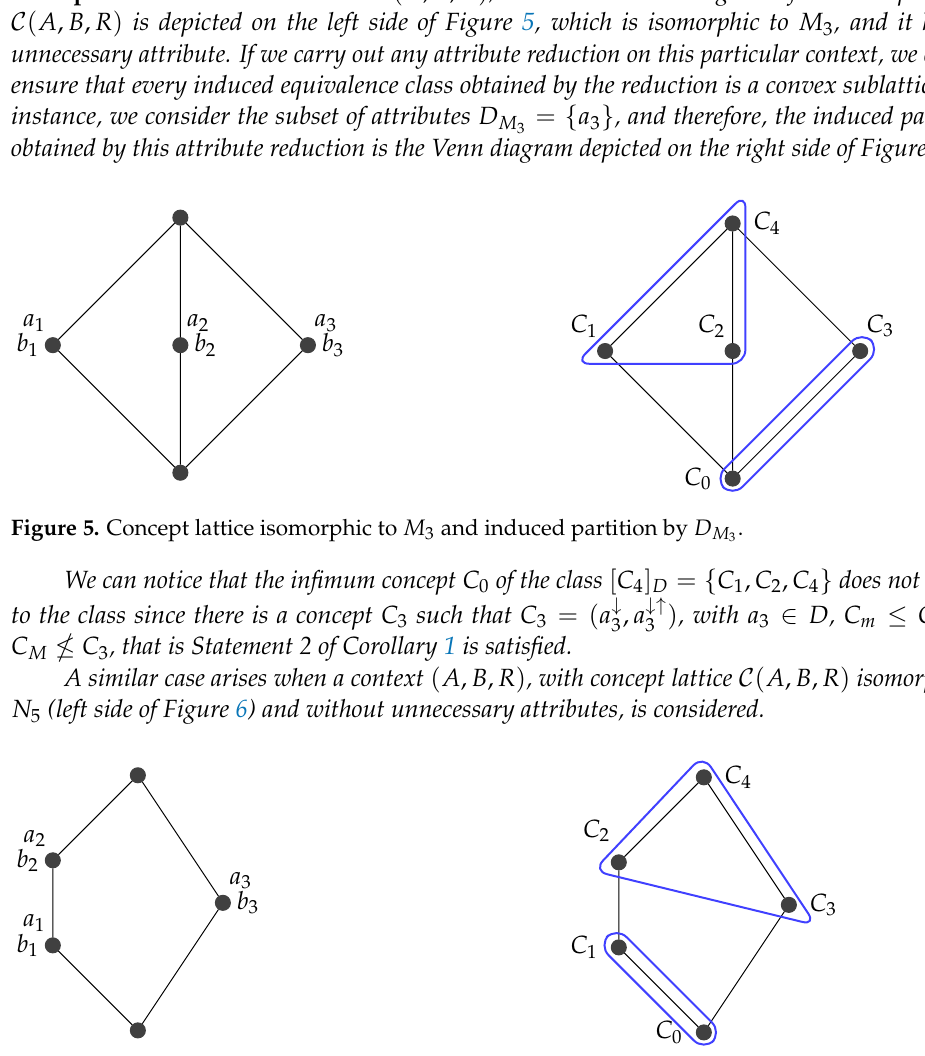
Figure 6. Concept lattice isomorphic to N 5 and induced partition by D N